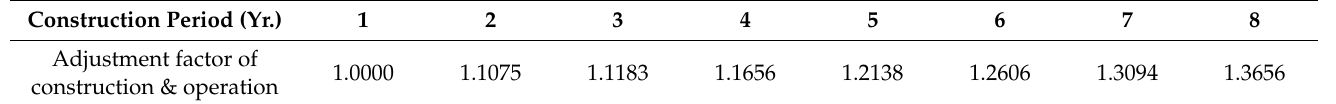
Table 2. Cash flow of payment during construction period based on the S curve.